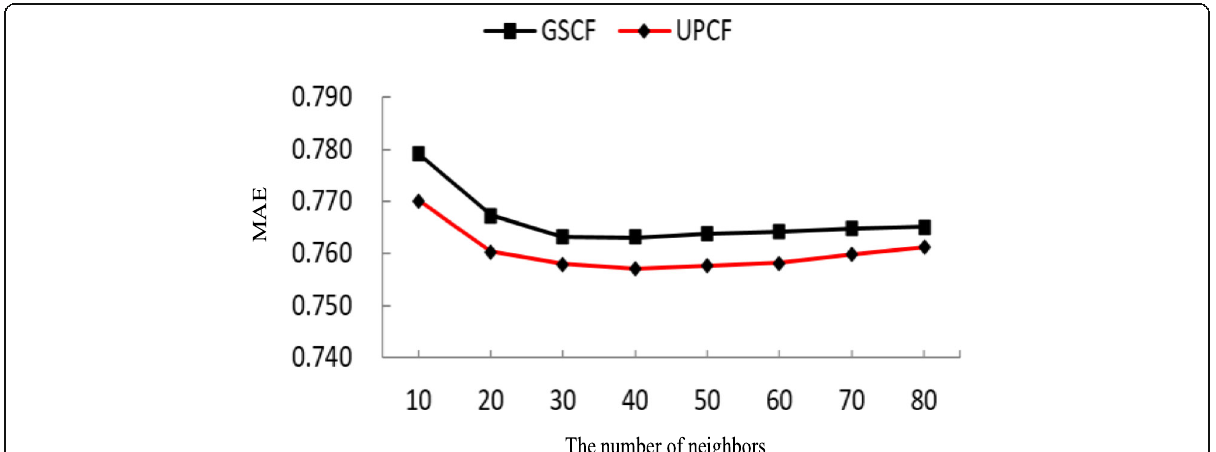
Fig. 8 Comparison of MAE values of two improved algorithms in a data set of train1. It can be seen from the graph that the MAE value of the two algorithms decreases first and then increases, and finally tends to be gentle. With the near neighbor number as the variable, when the near neighbor number is about 40, the MAE values of the two algorithms are the smallest, that is, the error is the smallest. Under the condition of the same neighborhood, the numerical MAE of the UPCF algorithm is lower than the GSCF algorithm. MAE value is smaller, which means that the scoring error of UPCF is lower than GSCF, that is, the recommendation effect of the algorithm UPCF is more accurate than the GSCF algorithm